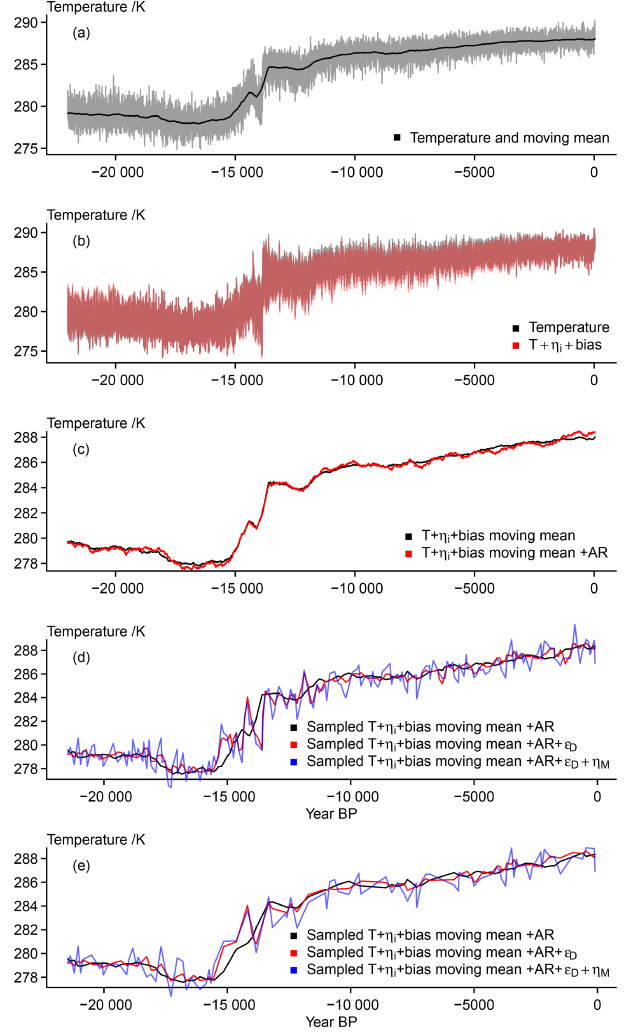
Figure 9. Visualizing the simplified essence of the surrogate proxy calculations: (a) input data and 501-point moving mean; (b) input data plus initial noise and bias term; (c) moving mean of input data plus noise plus bias and the same record plus an AR(1) process; (d) smoothed temperature plus noise plus bias plus AR process sam- pled at 200 dates, this record plus the effective dating error, and this record plus the effective dating error and measurement noise; (e) smoothed temperature plus noise plus bias plus AR process sam- pled at 100 dates, this record plus the effective dating error, and this record plus the effective dating error and measurement noise.